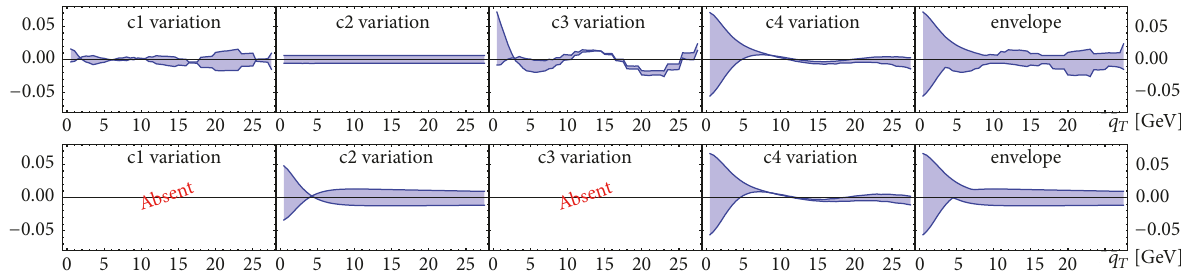
Figure 4: Comparison of error bands obtained by the scale-variations for cross sections at NNLO in traditional (upper figure) and optimal (lower figure) TMD implementation. Here, the kinematics bin-integration, etc., is for the Z-boson production measure at ATLAS at 8 TeV